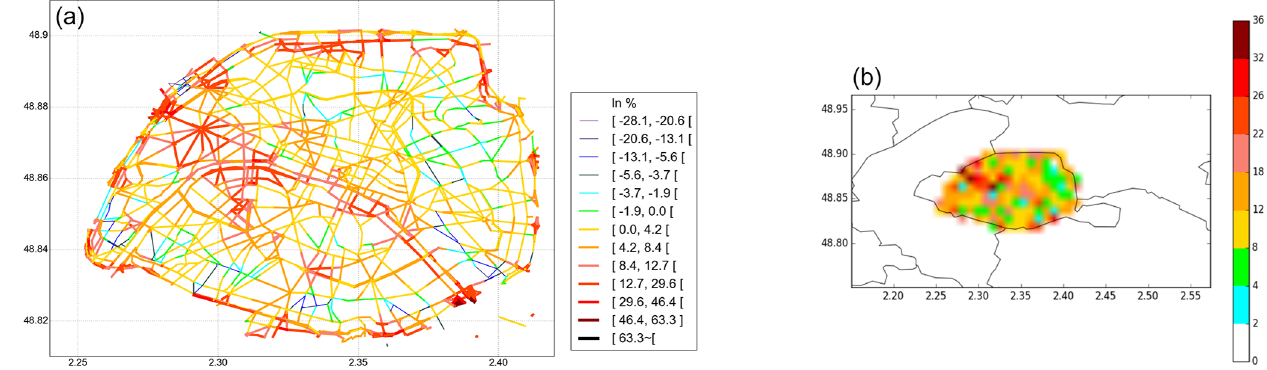
Figure 14. Relative differences (%) between NO 2 concentrations simulated by SinG and MUNICH at the local scale (a) and by SinG and Polair3D at the regional scale (b) .